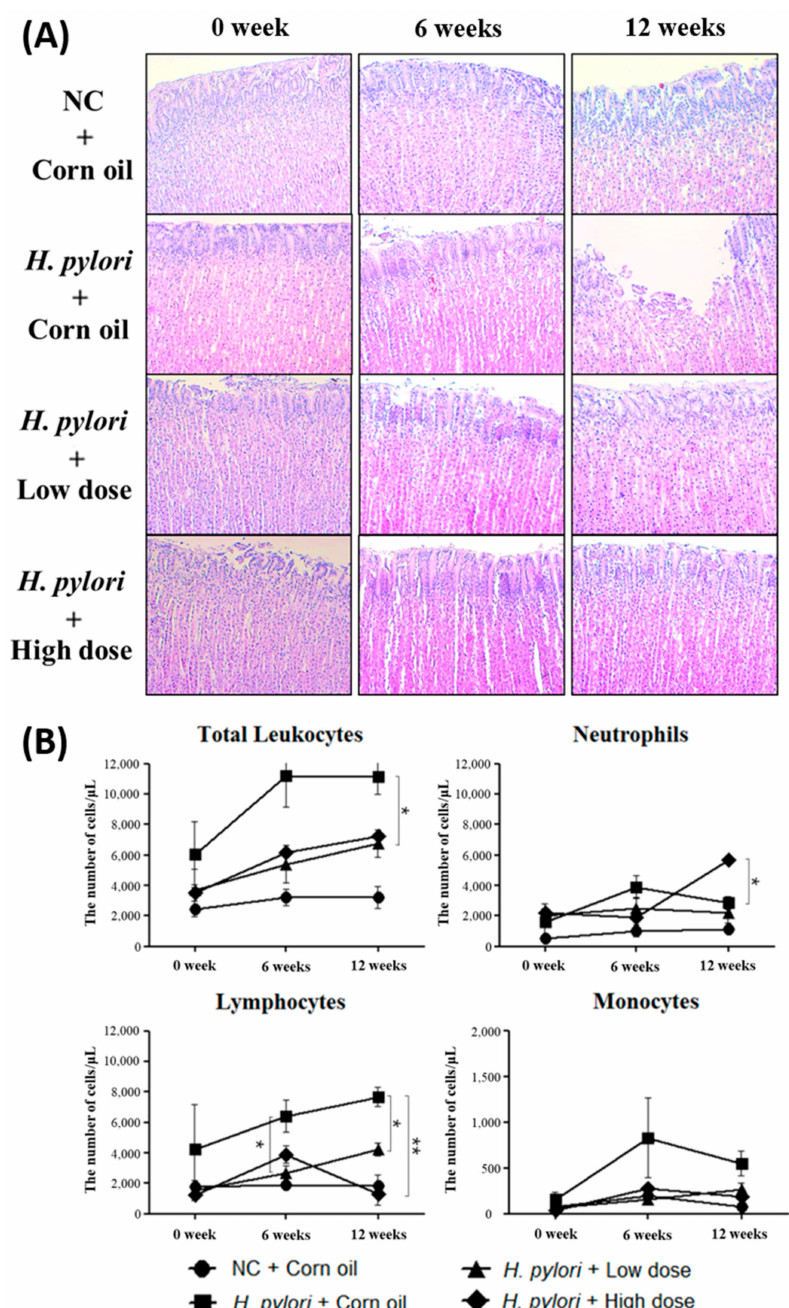
Figure 8. H&E staining of gastric mucosal layer and blood leukocyte count in H. pylori -infected Mongolian gerbils. ( A ) The stomach tissues from H. pylori -infected Mongolian gerbils were collected for H&E stain. Photomicrograph shows gastric mucosal layer of H. pylori -infected Mongolian gerbils ( × 200). ( B ) Blood was taken from H. pylori -infected Mongolian gerbils at the specified time after β -caryophyllene administration (0, 6, and 12 weeks) and subjected to blood cell counting. Data in the bar graphs are presented as mean ± SEM. The results were significant (* p < 0.05 and ** p < 0.01), as compared with the H. pylori control. Circle, NC + corn oil group; square, H. pylori + corn oil group; triangle, H. pylori + low dose group; diamond, H. pylori + high dose